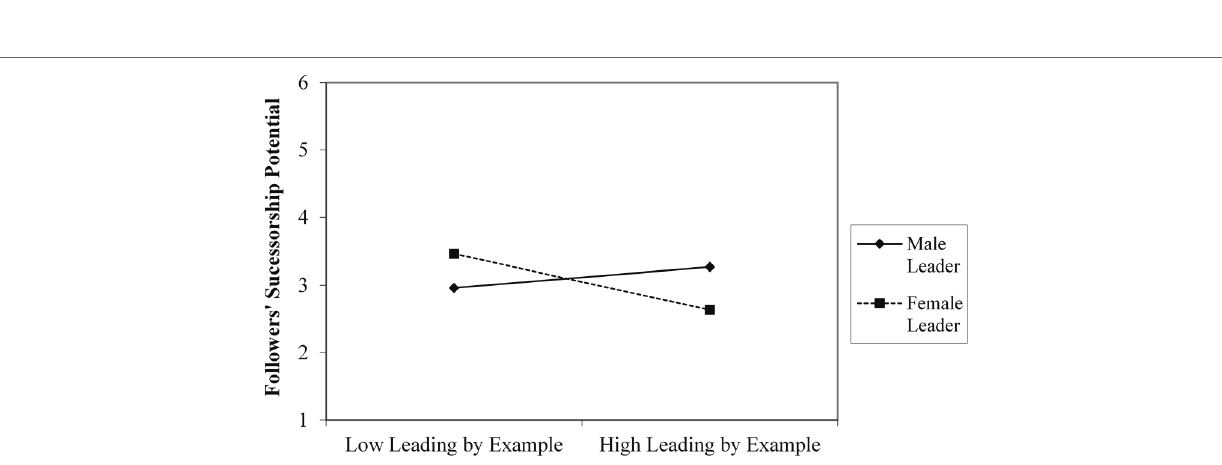
FIGURE 2 | Interactive relationship of followers’ evaluation of leaders use of leading by example and leader gender with leaders’ assessment of followers’ successorship potential (study